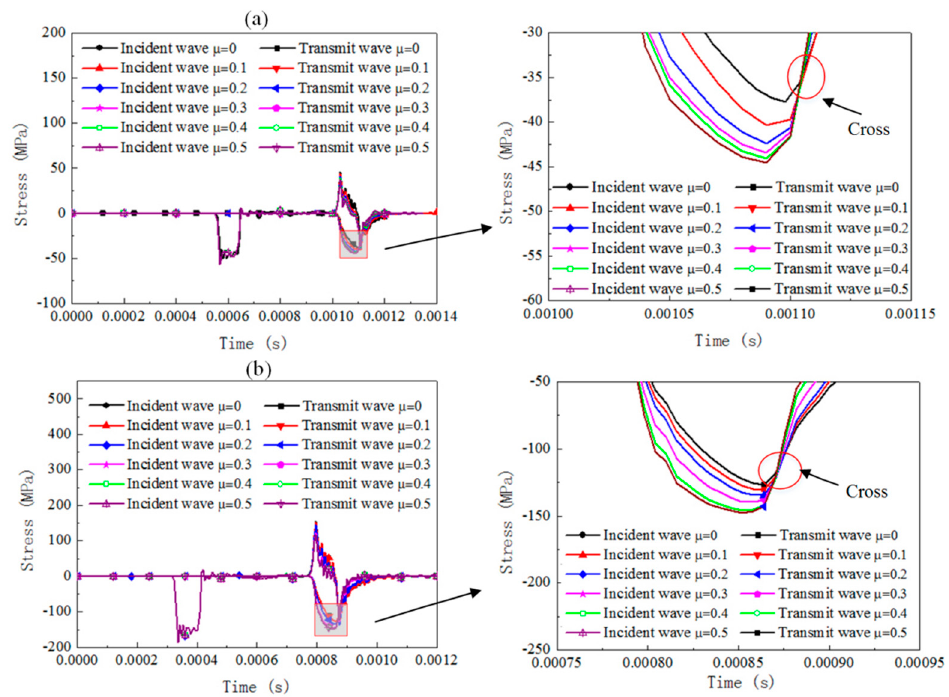
Figure 7. Comparison of the reflected and transmitted waves under different friction conditions and initial impact velocities for the rate-dependent viscoelasticity material (cylinder specimen with a slenderness of 0.66). ( a ) Impact velocity of 3 m/s, ( b ) impact velocity of 10 m/s.